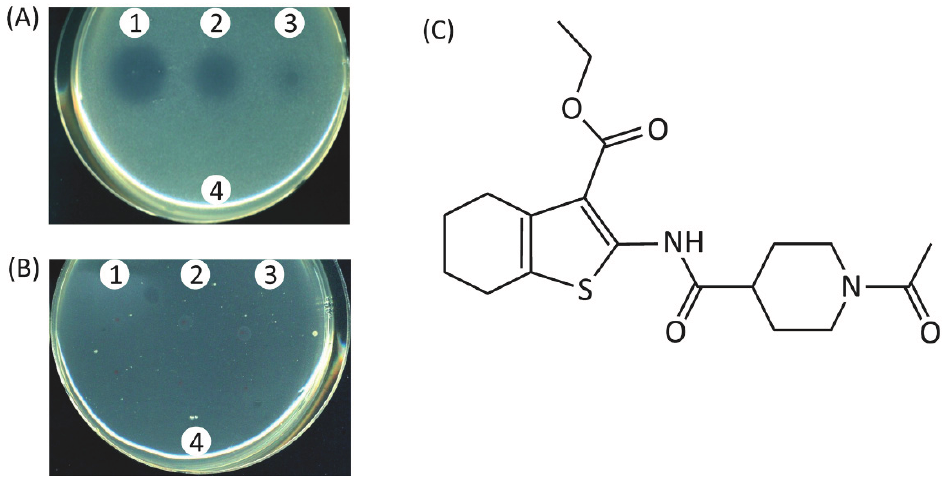
Figure 4. Effect of ethyl 2-(1-acetylpiperidine-4-carboxamido)-4,5,6,7-tetrahydrobenzo- [ b ]thiophene-3-carboxylate (YH001) on the growth of the test strain TNP091 ( Δ oprM